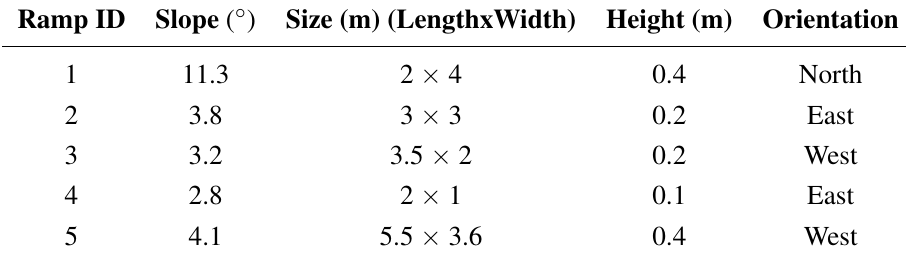
Table 1. Main features of the ramps in CAR-CSIC